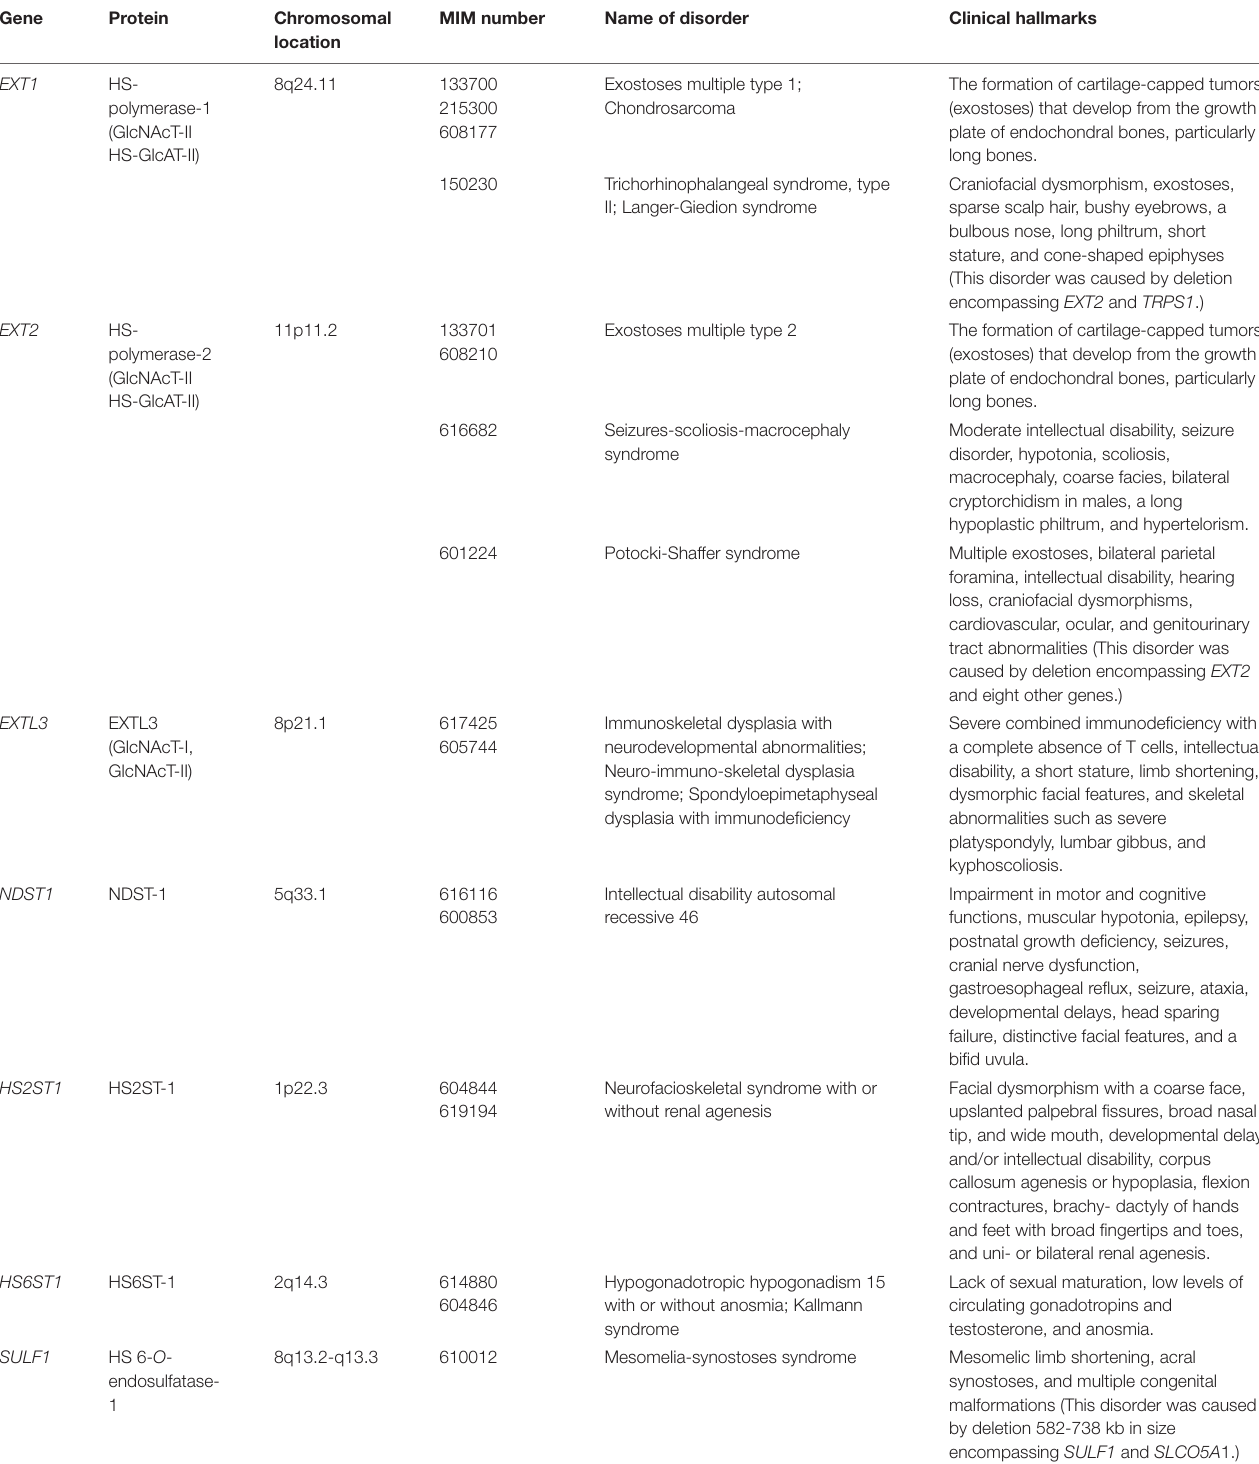
TABLE 3 | Congenital disorders of HS